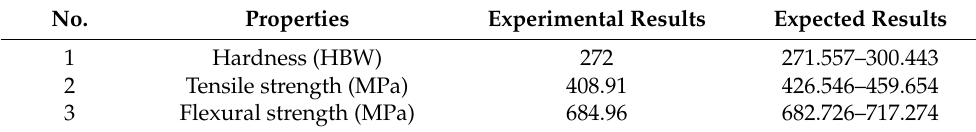
Table 13. Result of validation tests of Taguchi’s approach.